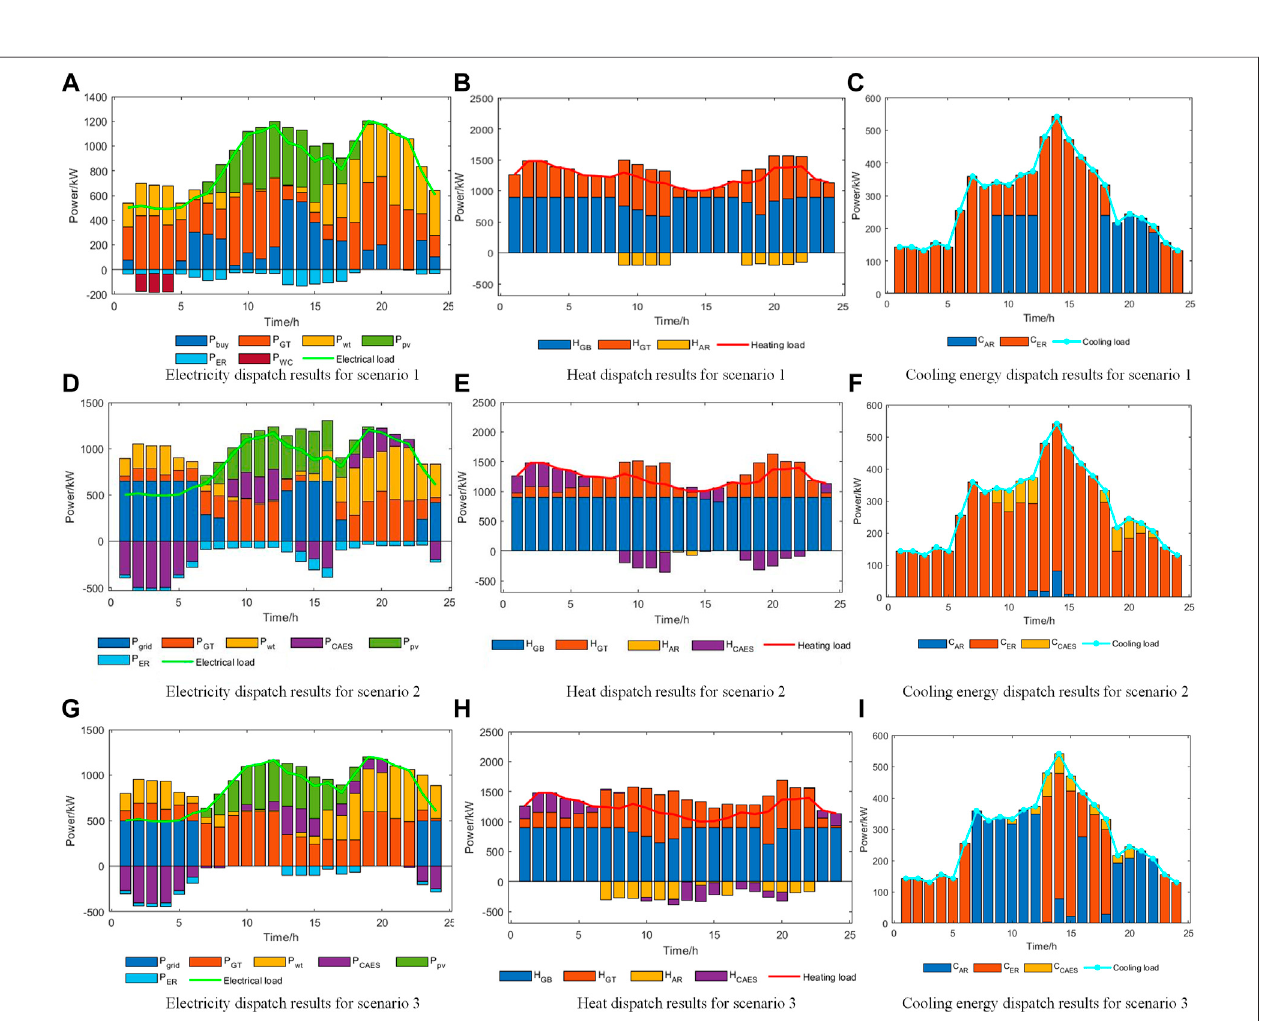
FIGURE 7 | Electricity, heat, and cooling dispatch results for scenarios 1 – 3.